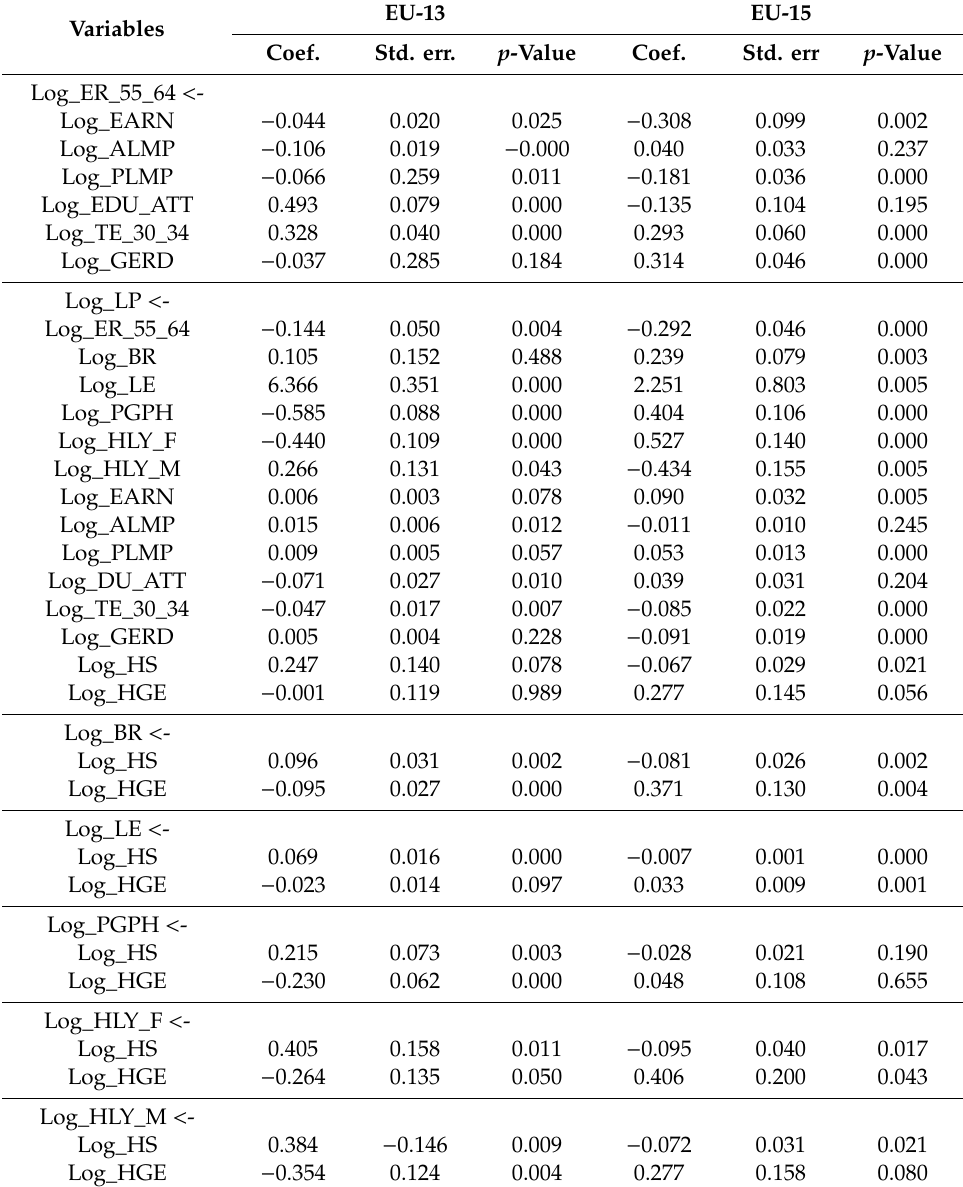
Table A2. Empirical results for SEM models designed to capture total e ff ects of population aging and public healthcare services on labor productivity in the EU, 1995–2017. Variables